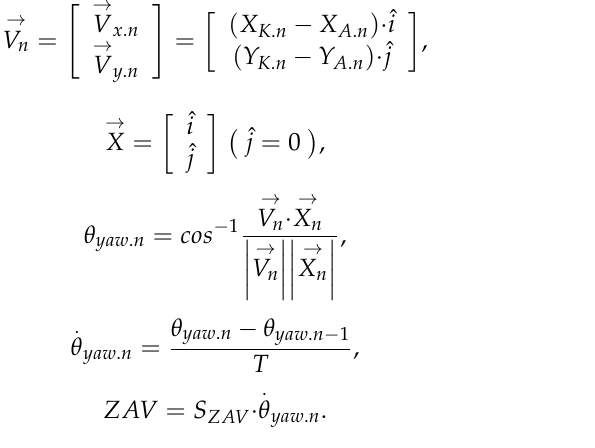
Figure 3. Flowchart explaining the algorithm process.